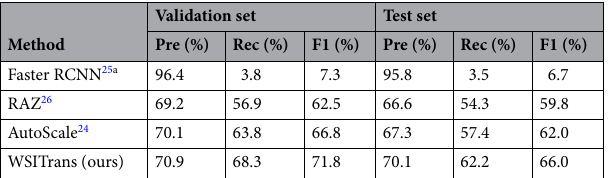
Table 3. Localization performance on NWPU-Crowd dataset. a Means the methods rely on box-level instead of point-level annotations.